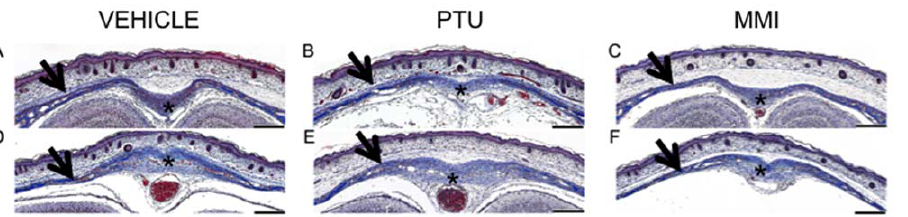
Figure 6. Representative histopathology of E18.5 calveria from vehicle, PTU and MMI treated mice. Histopathologic analysis of coronal sections through the head of E18.5 embryos from dams treated with (A, D) vehicle, (B, E) PTU (100 mg/kg), or (C, F) MMI (20 mg/kg) from E7.5 to E9.5 did not reveal any significant morphologic changes in the bones of the calveria (arrowheads) or the connective tissue stroma within the (A, B, C) frontal or (D, E, F) parietal sutures when compared to the skulls of control embryos. Representative sections from (A, B, C) rostral dorsal frontal bone at the level of the nasal cortex, and (D, E, F) caudal dorsal parietal at the level of the ears. Scale bars=200 m m. Masson’s Trichrome stained sections are